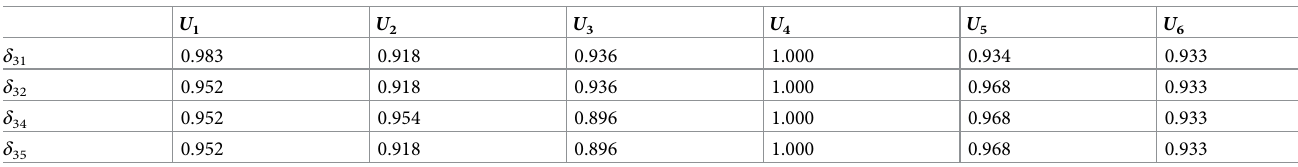
Table 16. The relative weight of O 3 to others.